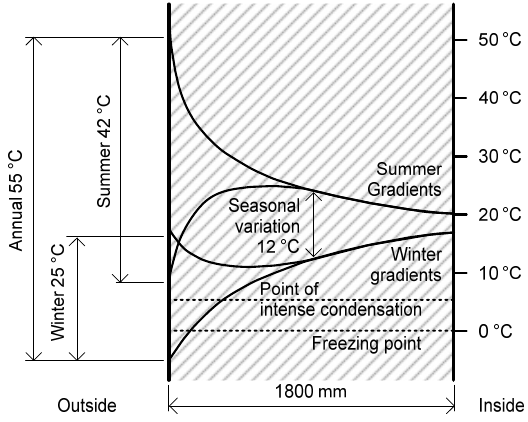
Figure 13. Theoretical temperature changes in a thick wall [25].